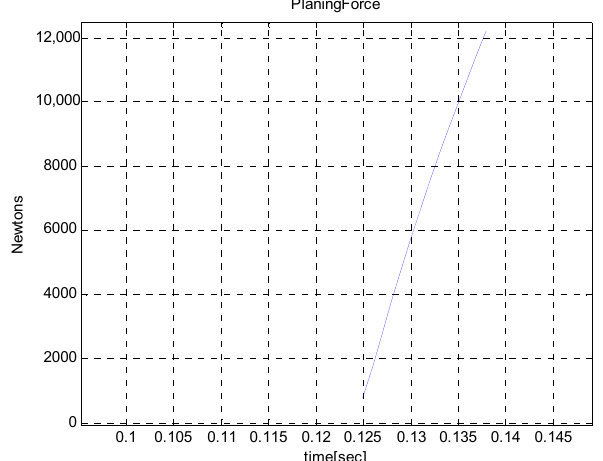
Figure 5. The planing force with respect to time (Proportional-Derivative (PD) depth controller).